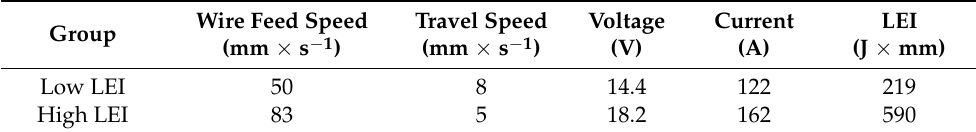
Table 2. Processing parameters of WAAM used in this study. LEI: linear energy input.